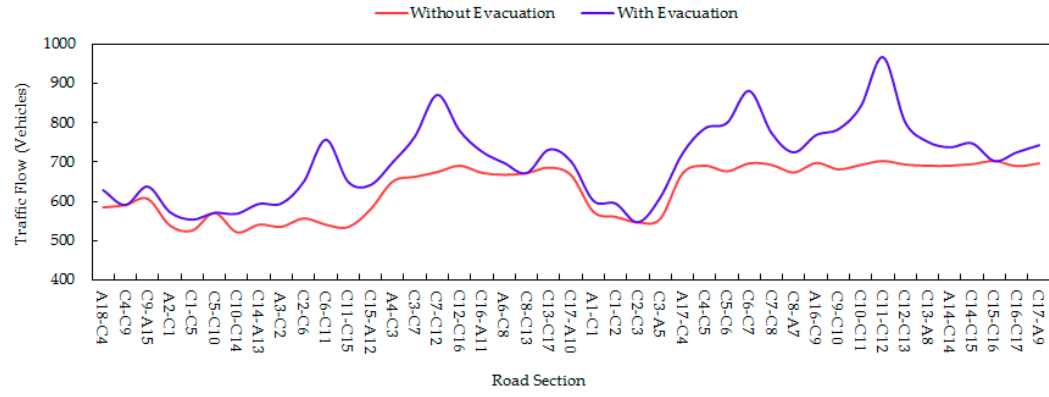
Figure 7. Tra ffi c flows on every road segment with and without evacuation. Figure 7. Traffic flows on every road segment with and without evacuation. Figure 7. Traffic flows on every road segment with and without evacuation.